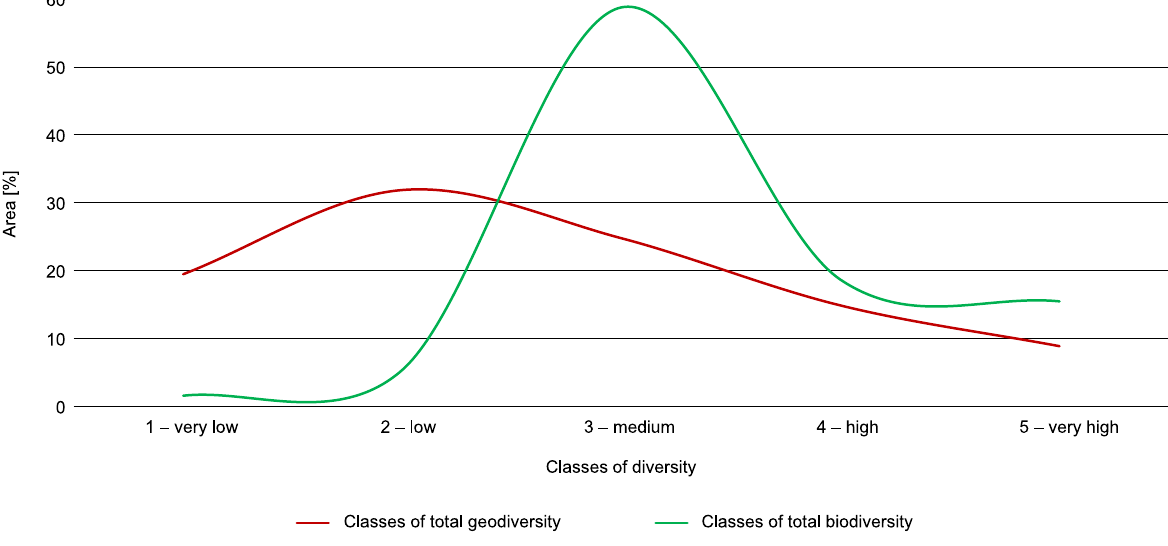
Fig. 12. ecodiversity pattern between geodiversity and biodiversity for dębnica river catchment (cf. Table 1 and